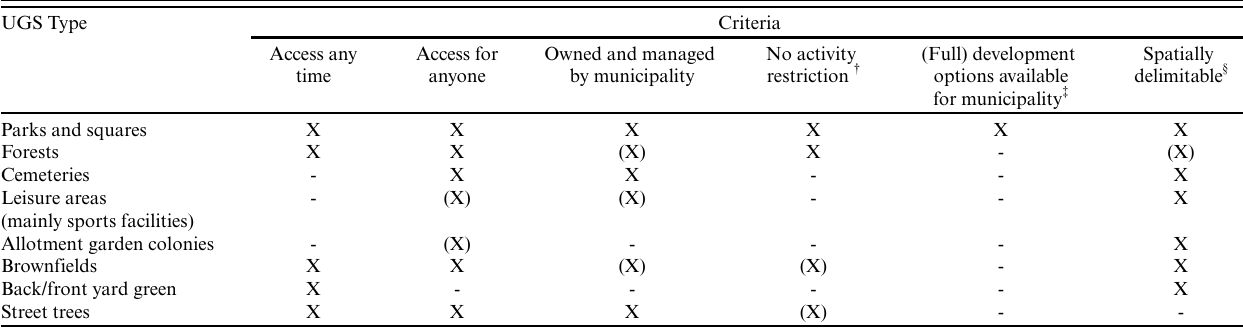
Table 1 . Set of criteria (checklist) used to define the focal urban green space (UGS) type for the study. Cases in brackets apply only partially to the respective UGS type, e.g., only minor parts of allotment garden colonies are accessible to anyone (shared areas); leisure (sports) areas are usually owned by the municipality but when leased by sports clubs they are often not accessible for anyone; forests are mainly owned by the federal state rather than by the municipality and are often hard to spatially delimit, i.e., no official demarcation data are available.